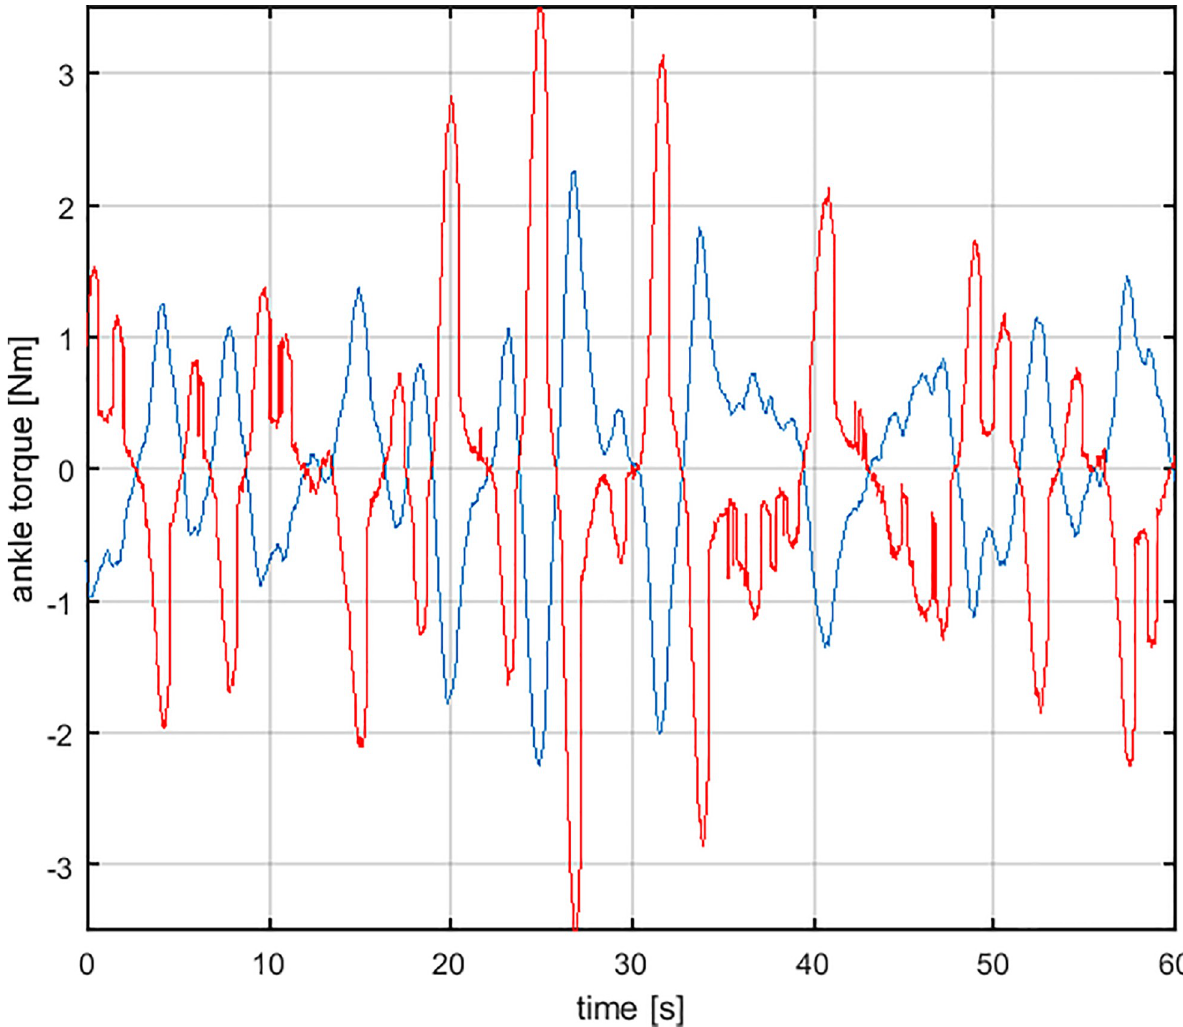
Fig 4. Stabilizing ankle torque generated by the simulation of the DIP/VIP hybrid control model. The DIP/VIP model (red trace) includes the stiffness component (passive, intrinsic, zero-delay feedback) and the intermittent control torque (active, delayed feedback). The counteracting ankle toppling torque due to gravity is displayed by the blue